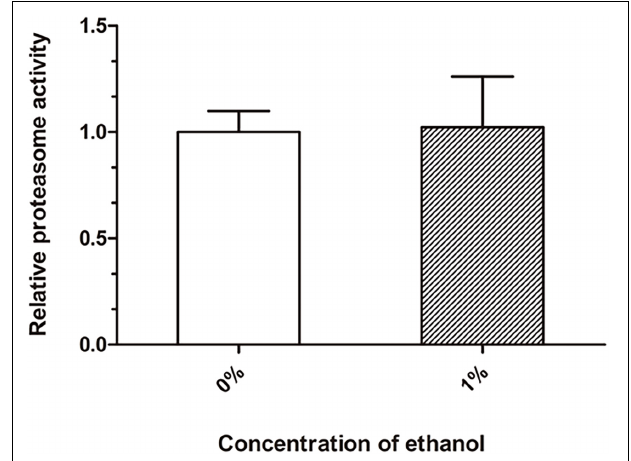
FIGURE 4 | Effect of ethanol on proteasome activity of C. elegans . The chymotrypsin-like proteasome activity was determined by the Suc-LLVY-AMC fluorescent substrate. Graphs represent mean ± SD, n =